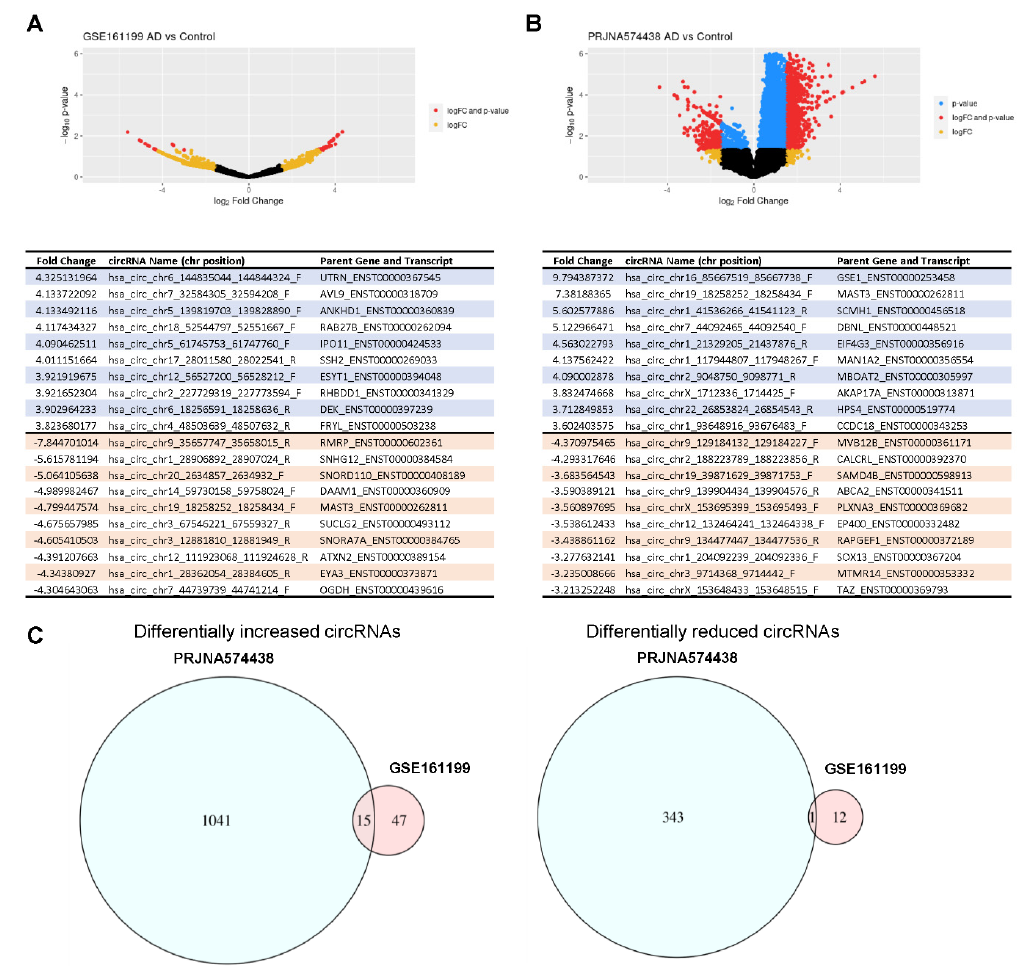
Figure 4. Differentially abundant circRNAs in plasma datasets. Volcano plot representations of the four studies using plasma study groups included in this analysis: GSE161199 ( A ) and PRJNA574438 ( B ). As explained in Figure 2, each point on these plots represents a specific circRNA with log fold-change (logFC) on the x-axis and p -value on the y-axis when comparing AD samples (plasma) with normal control individuals. The points in yellow represent circRNAs with only logFC greater than 1.5 (threefold higher), the points in blue represent circRNAs with only p -value < 0.05 (i.e., − log 10 ( p -value) > 1.3), and the points in red represent circRNAs both logFC > 1.5 (threefold lower) and p -value < 0.05. Below each volcano plot is a list of the top 10 most highly abundant (blue) and top 10 least abundant (orange) when comparing circRNAs in plasma from AD individuals relative to normal control individuals. ( C ) Venn diagrams represent the number of circRNAs in plasma more highly abundant in AD ( left ) and less abundant in AD ( right ) compared with control, and the studies where they were found.